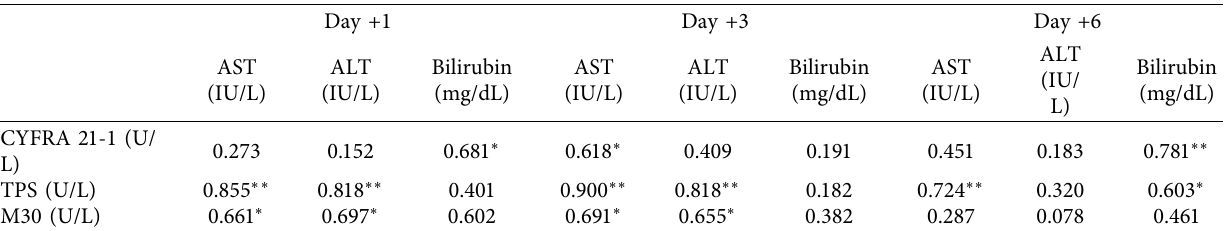
Figure 3: Time-course changes in the ratio between TPS and M30 after liver transplantation. Table 2: Correlation between serum keratin concentrations and standard liver markers in the immediate posttransplant